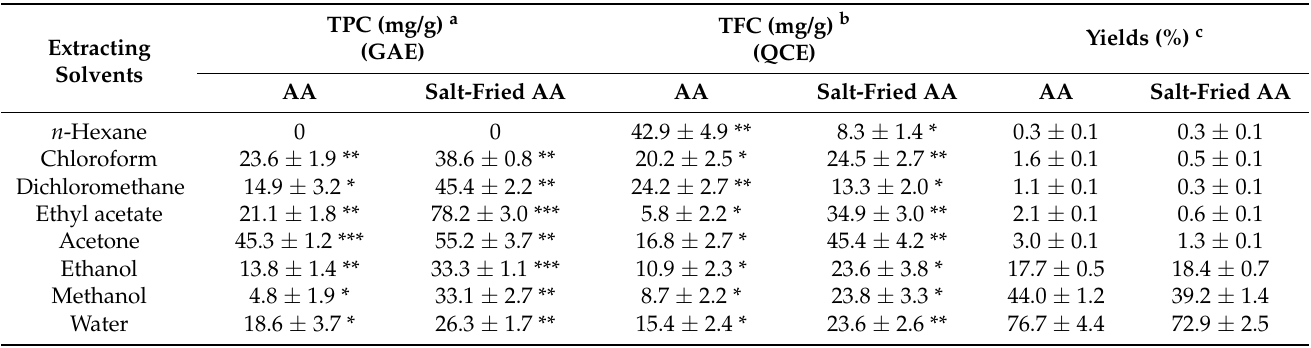
Table 1. Total phenol, total flavonoid contents, and extraction yields of Anemarrhena asphodeloides with each extraction